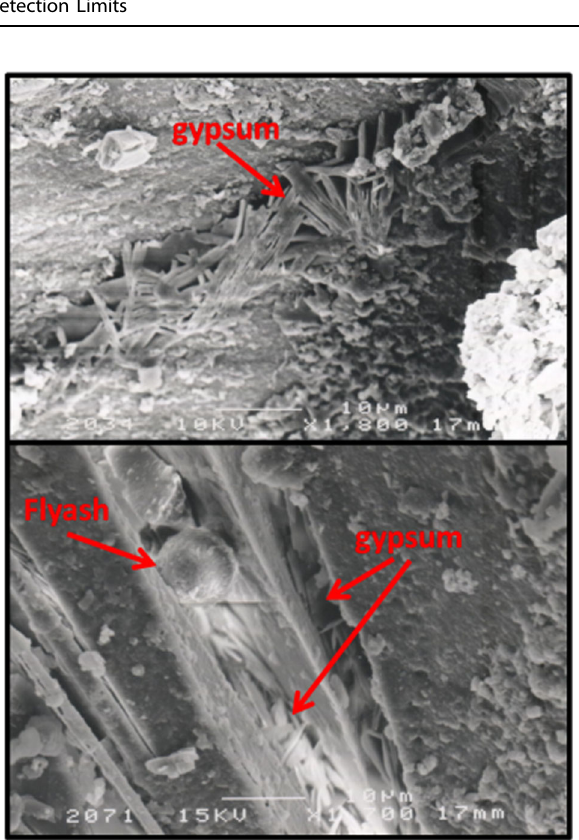
Fig. 3 Petrographic thin section of augen gneiss crusts. Petro- graphic thin section showing the formation of gypsum crystals in the microfractures of the stone below the crusts shown in Fig.